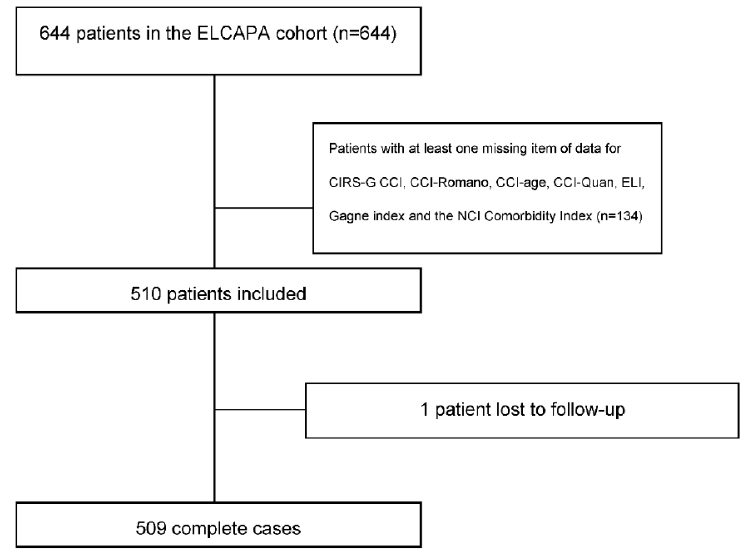
Figure 1. Study flow diagram: 26 missing items of data for the first 644 patients: tumor site ( n = 9), age ( n = 1), vital status ( n = 4), metastasis ( n = 16). Some patients lacked more than one item of